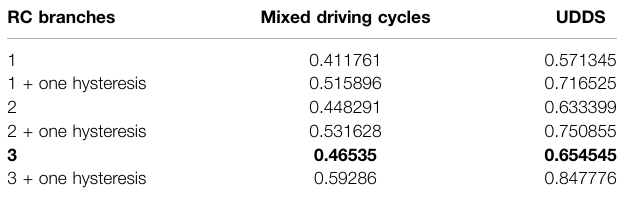
TABLE 9 | Time consumption of H-in fi nity with varying RC branches.